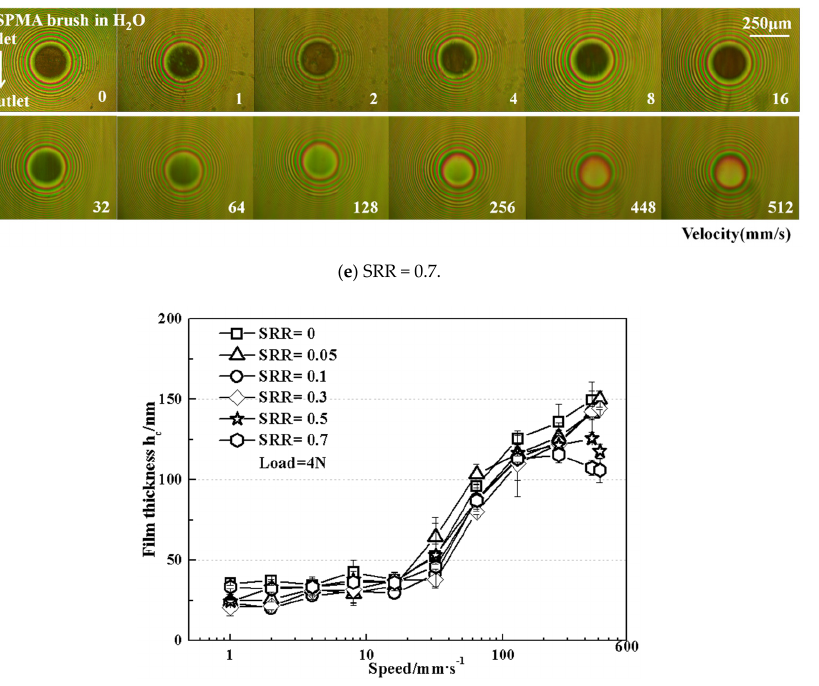
Figure 9. Optical interference images and film thickness curves of polymer brush PSPMA with different entrainment speeds under different slip-to-roll ratios: ( a – e ) is the light interference diagram for different slip ratios of SRR = 0.05, 0.1, 0.3, 0.5, and 0.7; ( f ) is the film thickness under the load of 4 N and different slip-roll ratios.